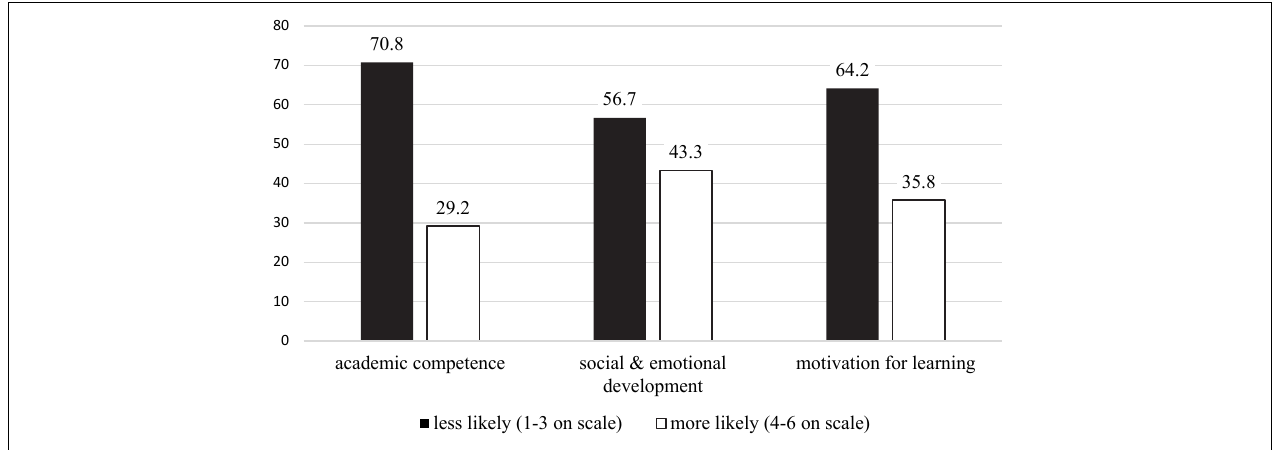
FIGURE 2 | Percentage of teachers indicating that students are more vs. less likely to experience long-term negative impacts of the Corona pandemic in three areas.